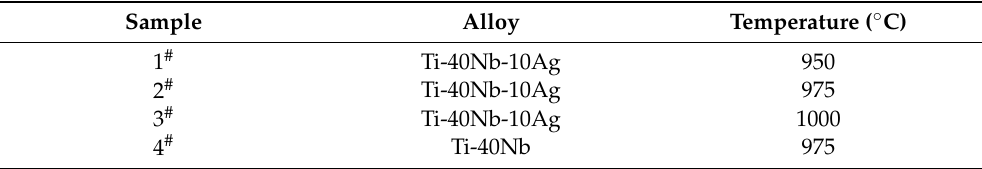
Table 1. The processing parameters of experimental